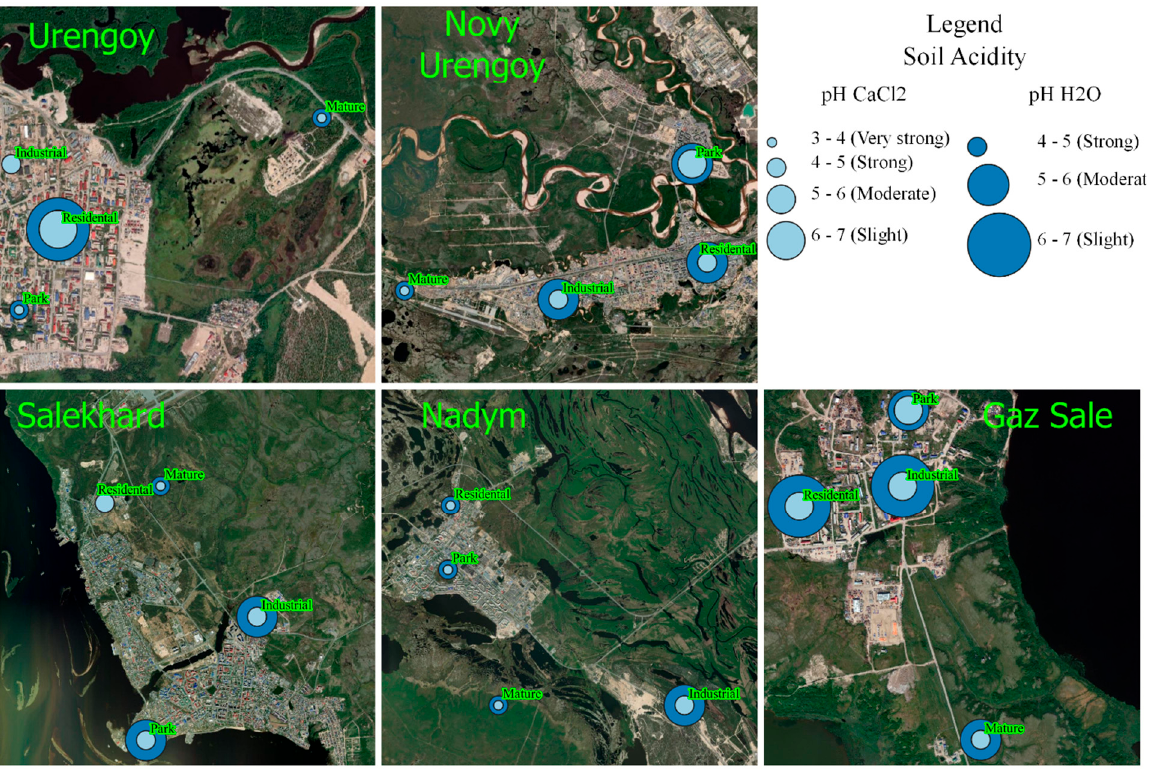
Figure 3. Soil pH values in different functional zones of the studied cities.